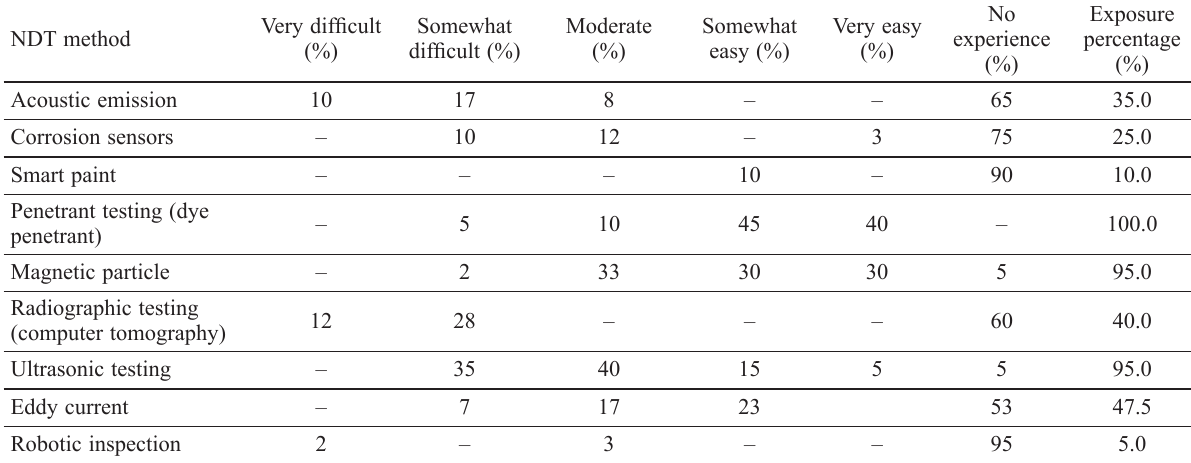
Table 9. Steel NDT methods: difficulty score NDT method